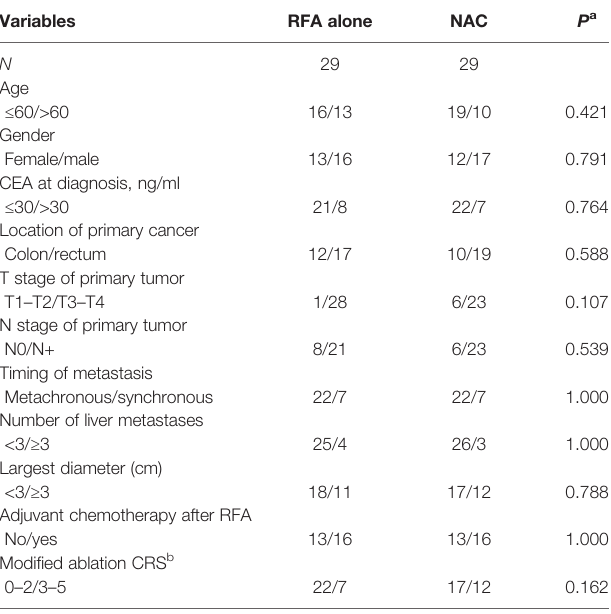
TABLE 2 | Baseline characteristics of the patients after propensity score matching.